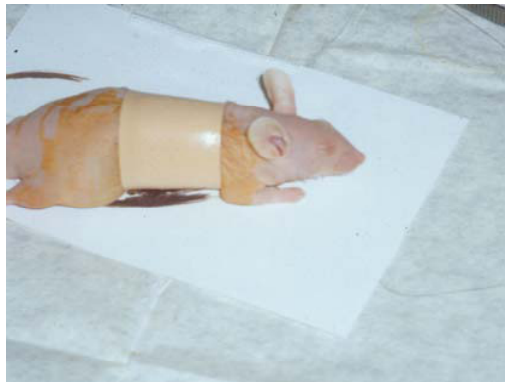
FIGURE 4 – Band-Aid ® over sutured dressing transversal to cranial-caudal